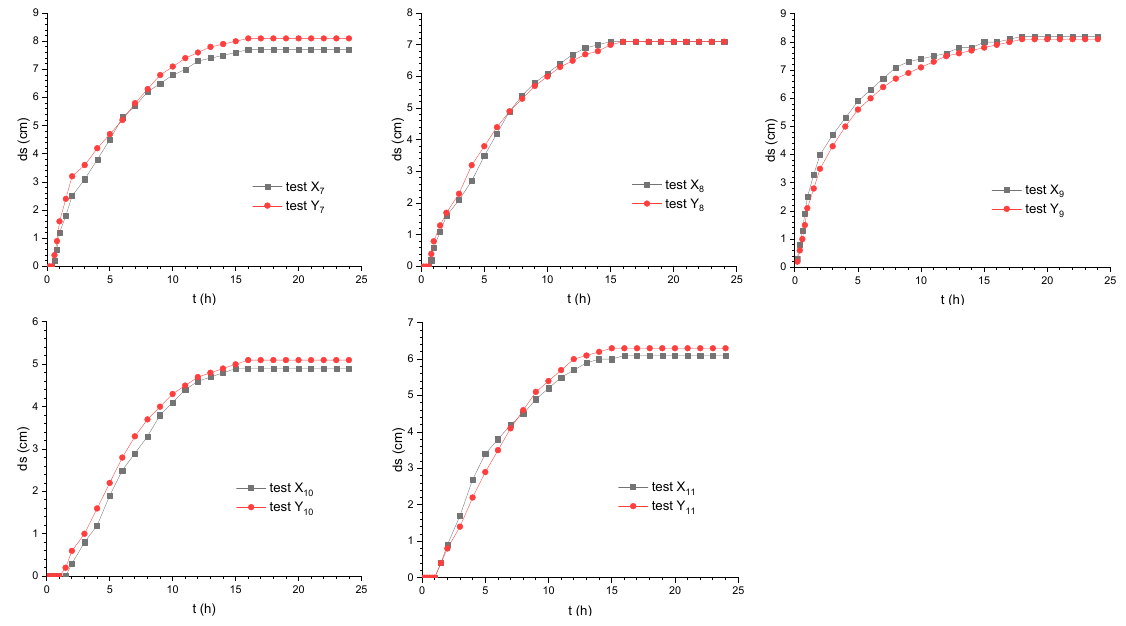
Figure 8. Comparison of the time variation of scour depths in corresponding tests of series X ( d 50 = 0.71 mm) and Y ( d 50 = 0.98 mm) with pier modifications ( X 1 –X 11 , Y 1 –Y 11 ; D p = 5 cm): tests X 1 and Y 1 , ……. tests X 11 and Y 11 .